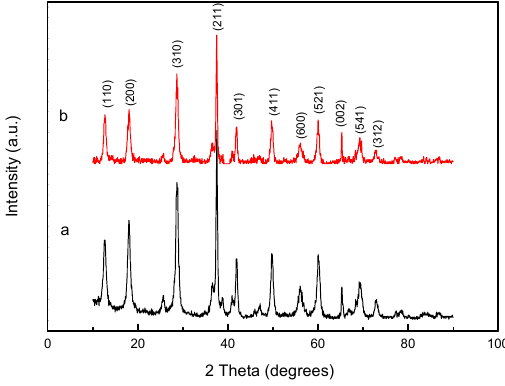
Figure 2. XRD patterns of (a) α -MnO 2 nanorods and (b) BISIN.